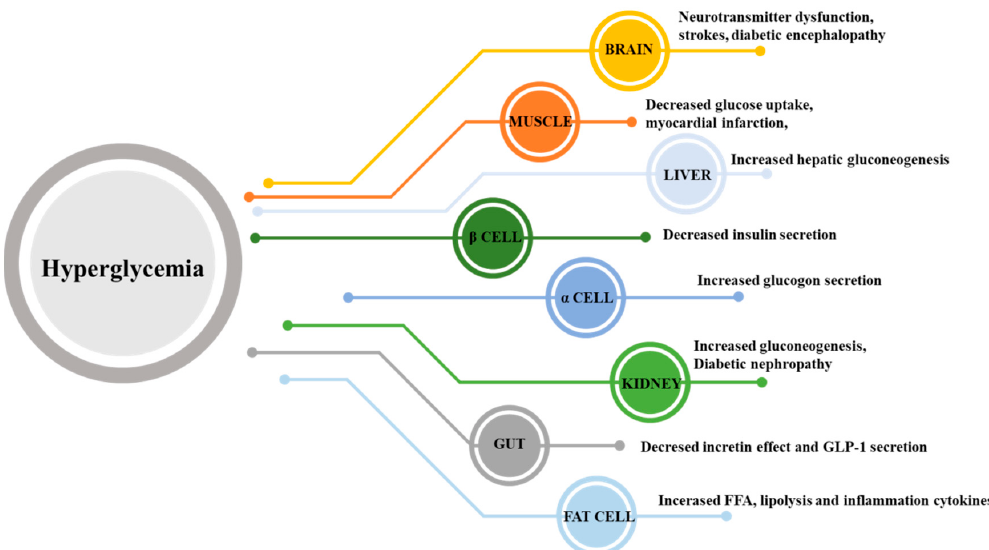
Figure 2. The ominous octet. Multiple defects of organ result from the development of glucose intolerance in T2D. The classical organ systems are targets for which available, including the pancreatic islet, liver, muscle and adipose tissue. The non-classical new organs interventions have been new targeted, have been more focus recently, including the intestine, kidney and brain.